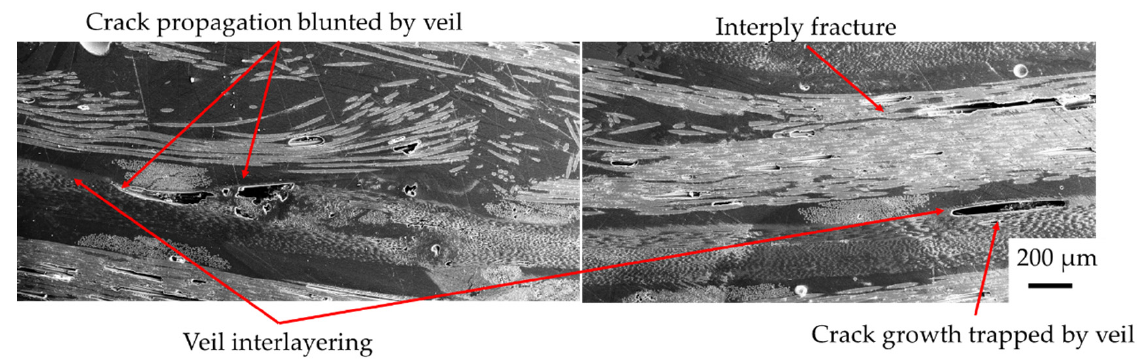
Figure 22. Veils effect of localisation of failure within the CTGTCTG, showing localisation leading to interplay failure preventing glass/carbon fibre interfacial delamination. Note this is the same sample with two images taken of different areas.